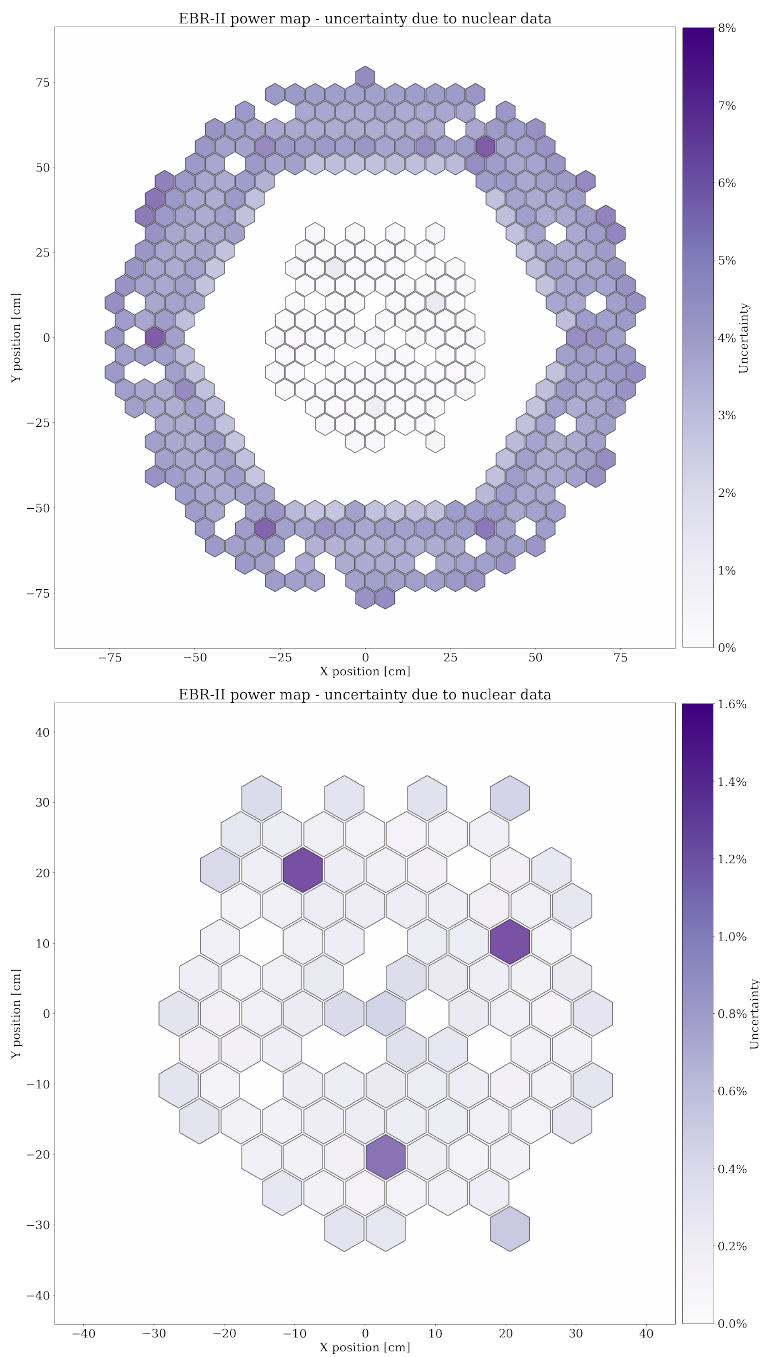
Figure 12. Sampler/KENO-MG uncertainty of axially integrated assembly powers using ENDF/B-VII.1 data: whole core ( top ) and inner driver core ( bottom ). Note the different ranges of the color map for the two